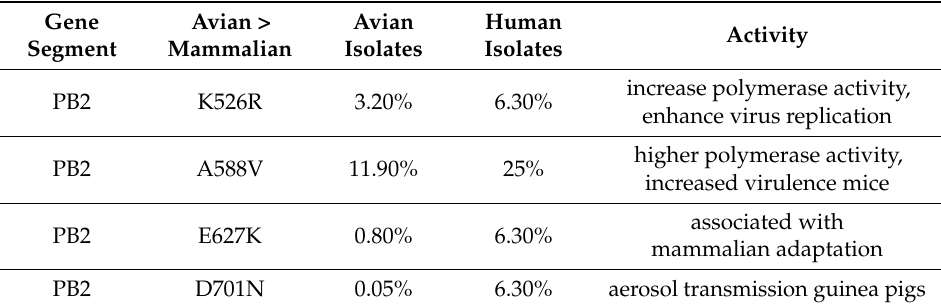
Table 4. Comparison of molecular markers of human adapted influenza